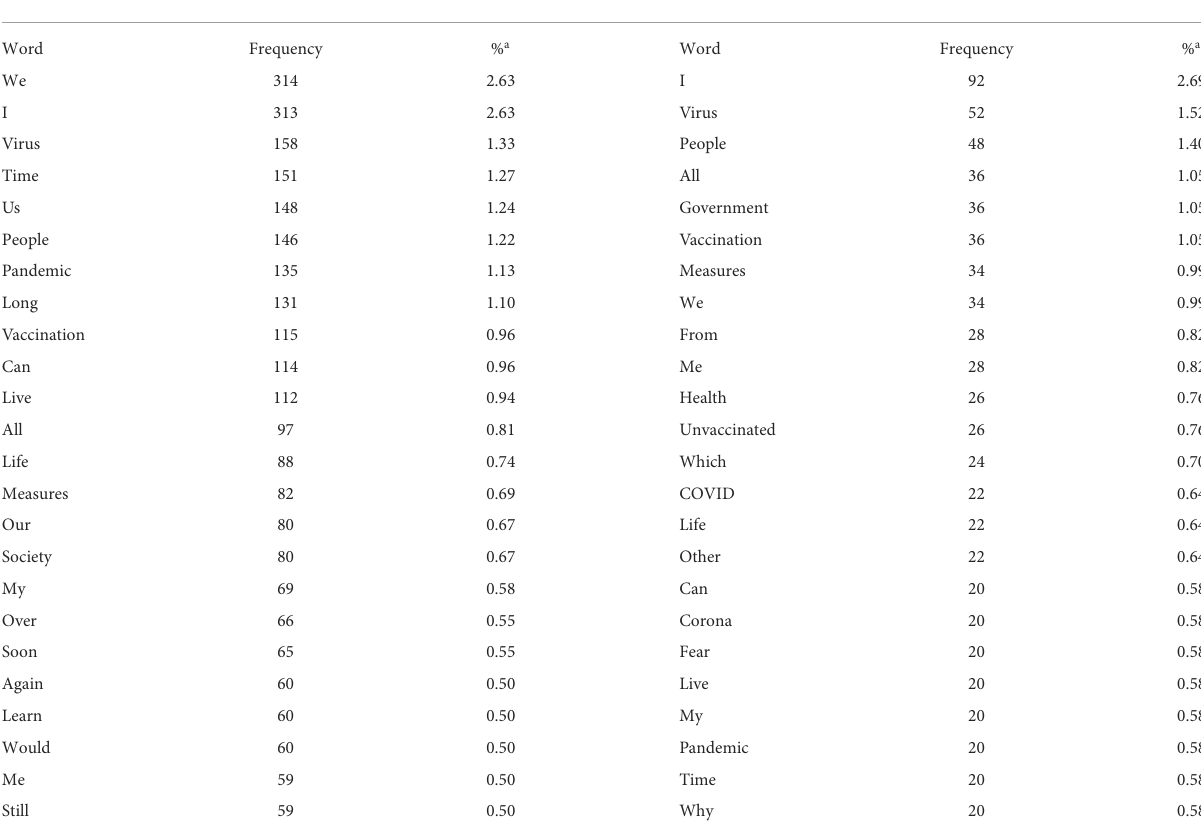
TABLE 5 Word frequencies of the 25 most frequent words for item 1 (“When I think about the COVID-19 pandemic, I believe”) in the Believing Questionnaire for the two groups.